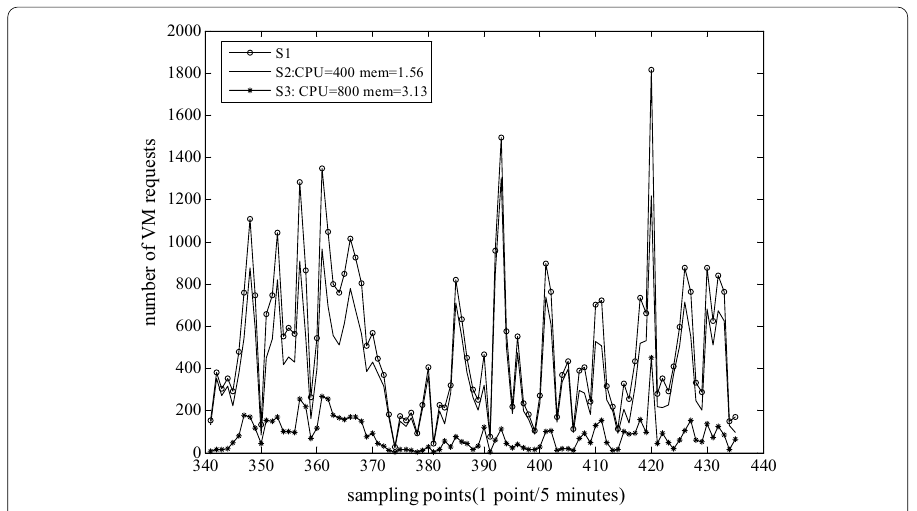
Fig. 4 Number of new VMs created for online services. The S1 curve depicts the total number of 28 types of new VMs. The S2 and S3 curves depict the quantities of new VMs for the type of CPU and the type of CPU 800 and mem 3.13, respectively = =